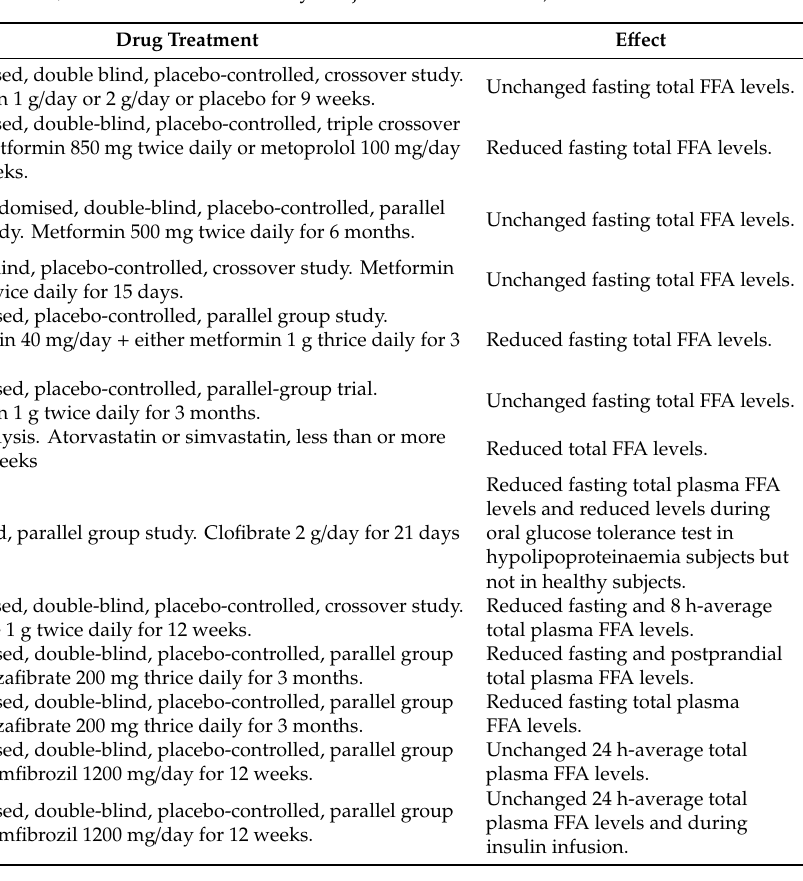
Table 3. List of studies having measured the total FFA concentrations in the blood from subjects treated with particular lipid-lowering drugs and characteristics of the populations studied. Studies shorter than 1 week, not comparing the e ff ect of the drugs to a placebo or done on population with diseases other than T2DM, glucose intolerance, insulin resistance, obesity, metabolic syndrome or dyslipidaemia were excluded, while studies on healthy subjects were